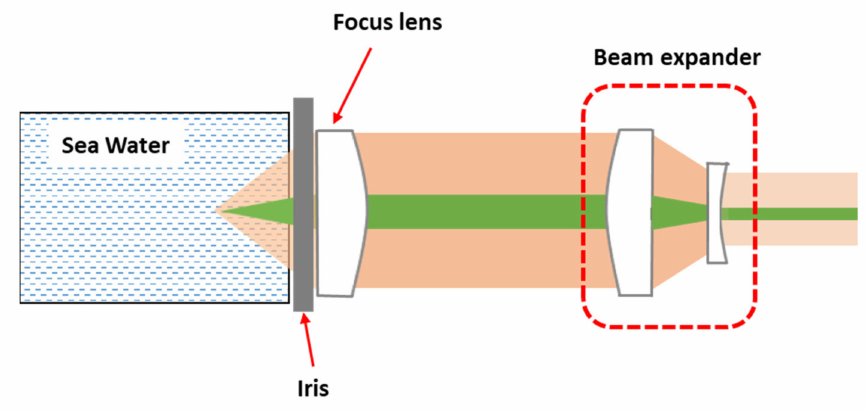
Figure 3. Schematic diagram of the tunable-aperture